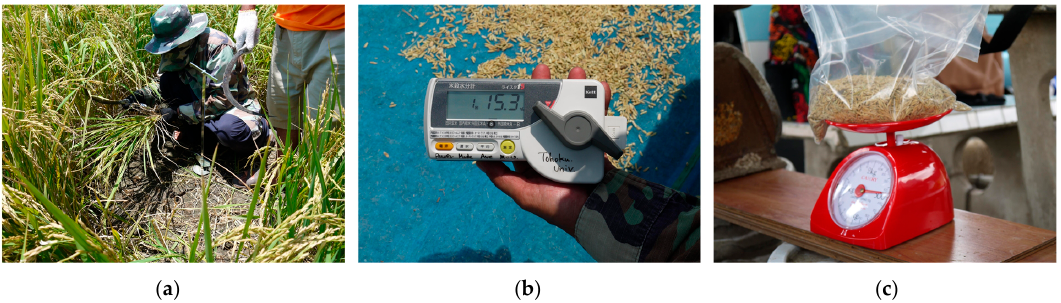
Figure 4. Yield data collection activities at harvest: ( a ) crop cutting in a 1 × 1 m 2 plot, ( b ) measuring grain moisture content, and ( c ) weighting grains at 0% moisture content.